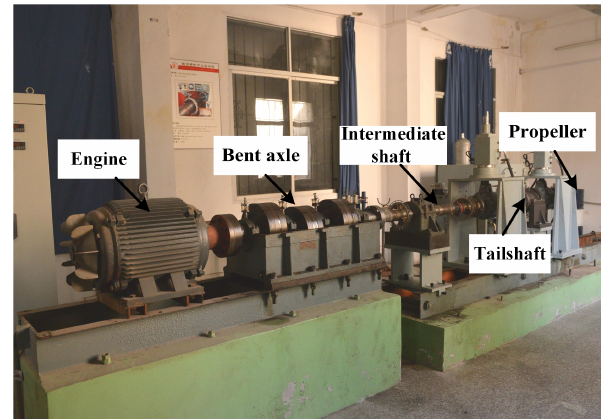
Figure 1. Physical drawing of the propulsion shaft test bench.